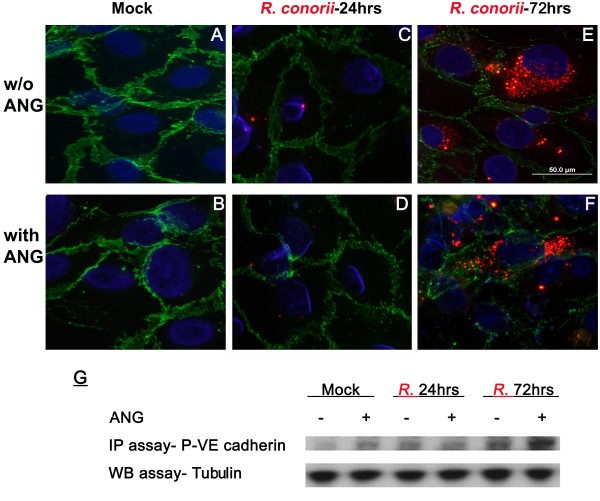
R. conorii infection-initiated cytoplasmic translocation of exogenous rANG enhanced VE-cadeherin internalization into endothelial cells and tyrosine phosphorylation of VE-cadherin at 72 hrs p.i. Dual immunofluorescence staining of SFG rickettsiae (red) and VE-cadherin (green) in human umbilical vein endothelial cells (HUVECs) using a dual wave length filter system revealed that internalized VE-cadherin could be detected at 72 hrs p.i. (image E), compared to mock and 24 hrs p.i. (image A, C). Addition of rANG shows an enhancing effect on the internalization of VE-cadherins in HUVECs at 72 hrs p.i. (image F). A representative immunoprecipitation (IP) study suggested that exogenous rANG enhances phosphorylation of VE-cadherin (p-VE-cadherin) at 72 hrs p.i. (image G). Nuclei of HUVECs are counter-stained with DAPI (blue).